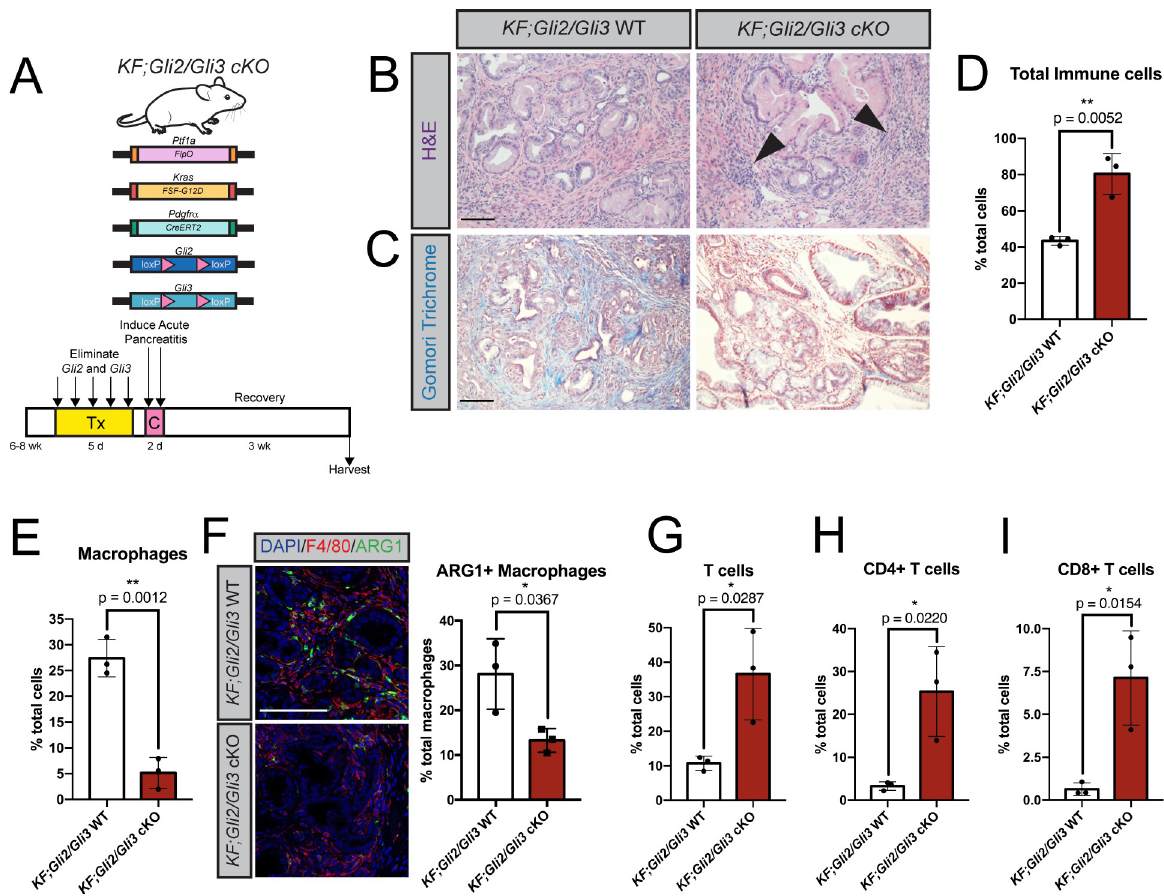
Fig 2. Conditional Gli2 and Gli3 deletion in vivo restricts immunosuppressive macrophages and promotes T cell infiltration. A ) Cartoon depicting experimental strategy. Adult KF; Pdgfr α CreERt2/+ ; Gli2 fl/fl ; Gli3 fl/fl ( KF;Gli2/Gli3 cKO) mice were given tamoxifen (Tx, 200mg/kg) once a day for 5 days. Mice were then given 8 hourly injections of caerulein (C) over 2 days to induce pancreatitis. Pancreata were harvested 3 weeks later. B-C ) H&E ( B ) and Gomori trichrome ( C ) staining of KF;Gli2/Gli3 cKO mice (right) and KF; Gli2 fl/fl ; Gli3 fl/fl ( KF;Gli2/Gli3 WT) mice (left). Arrowheads indicate dense pockets of stromal cells. D-E ) Flow cytometry analysis of total immune cells ( D ) and macrophages ( E ) in KF;Gli2/Gli3 WT and KF;Gli2/Gli3 cKO mice. F ) Immunofluorescent antibody detection (left) and quantitation (right) of macrophages (F4/80, red) expressing arginase 1 (ARG1, green). DAPI staining in blue. G-I ) Flow cytometry analysis of total T cells ( G ), CD4+ T cells ( H ), and CD8+ T Cells ( I ). N � 3 for all genotypes. All P-values were determined by un-paired t-test. Scale bars = 100 μ m. Mouse drawing acquired from the open source